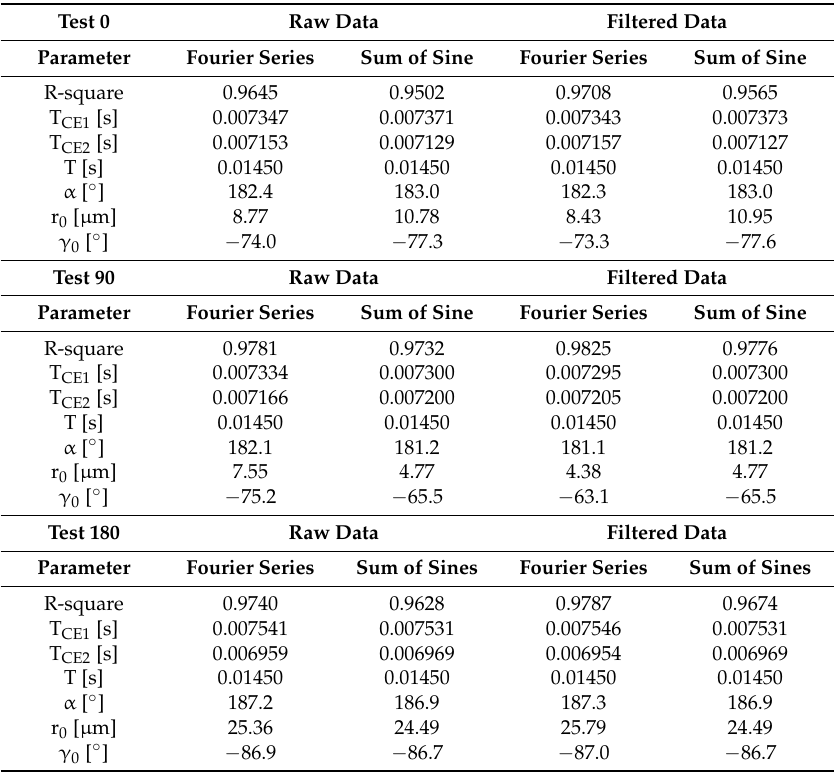
Table 5. Fitting functions results: T CE1 , T CE2 , T, α , r 0 , γ 0 , SSE and R 2